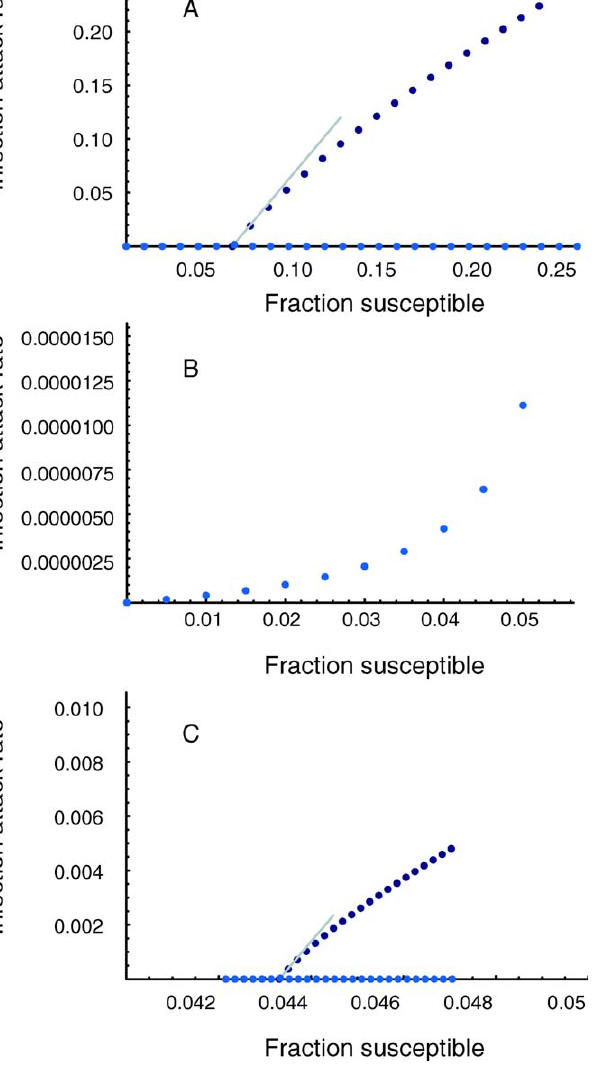
Figure 1. The Epidemic Threshold